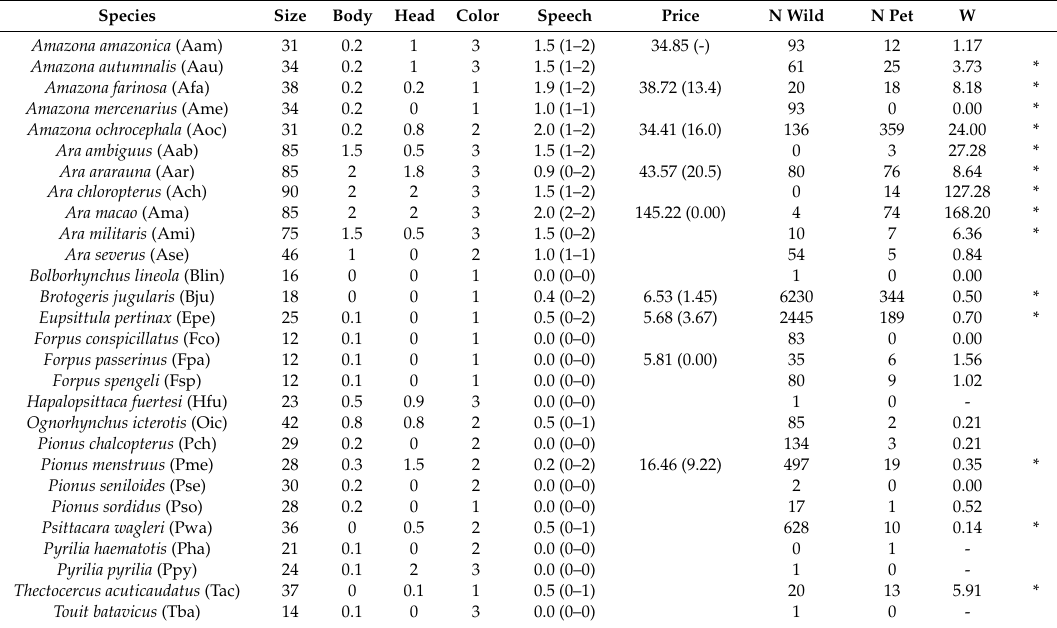
Table 2. Parrot species included in the study, their body size (in cm), the scores (0–2) for the brightness of body and head coloration, the total number of colors (Color), their ability to imitate human speech (speech, 0–2, with ranges), their price in US$ (with SD), the number of individuals recorded in the wild (N wild) and as poached pets (N pet), and the Savage selectivity index (W). * Statistically significant W values after Bonferroni correction ( p <